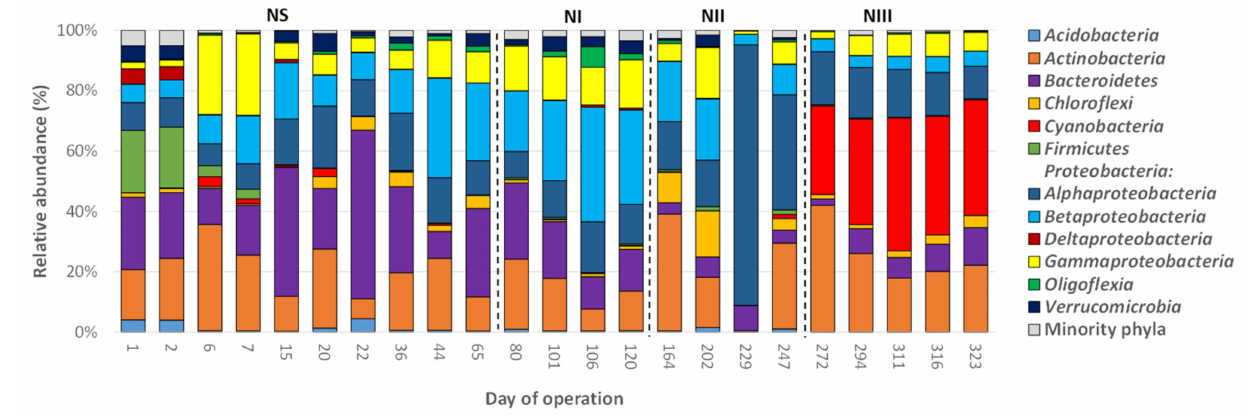
Figure 3. Average relative abundance of the main bacterial phyla (RA > 0.5%) found in biomass samples from an enrichment SBR operated under non-saline conditions (SBR-N, 0.5 g NaCl/L).